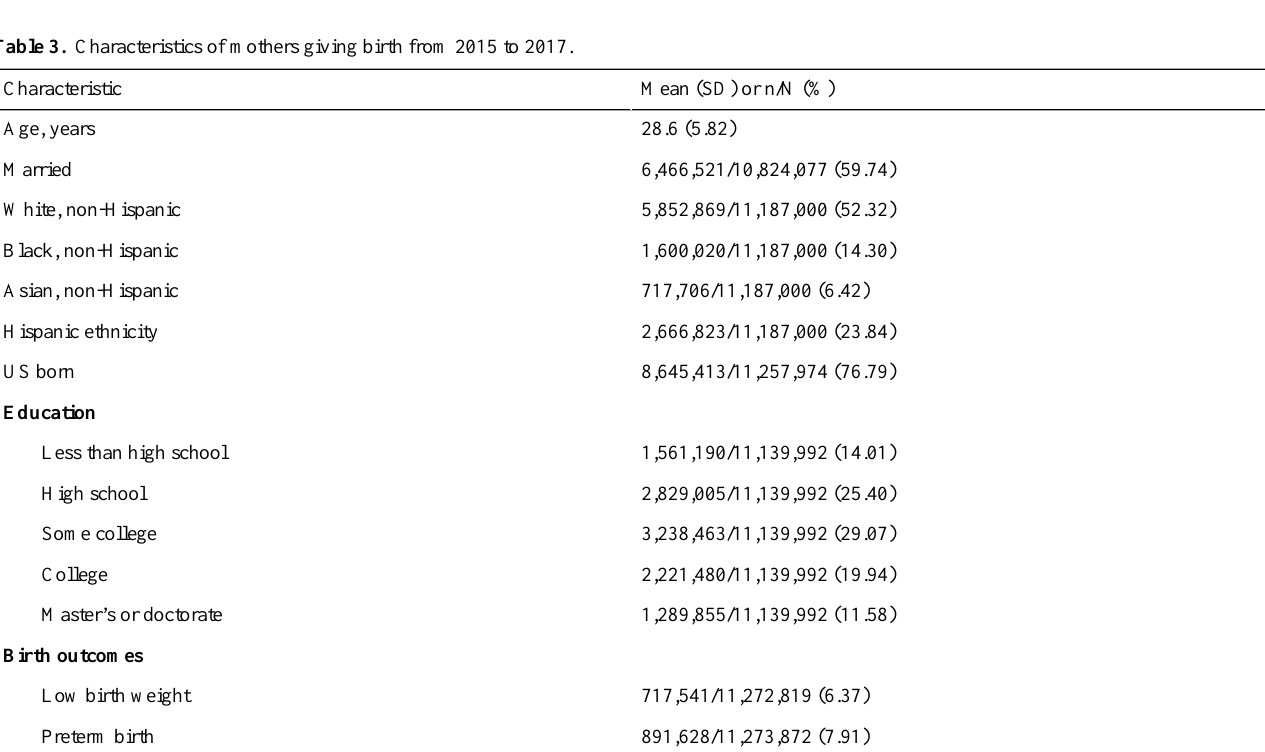
Table 3. Characteristics of mothers giving birth from 2015 to